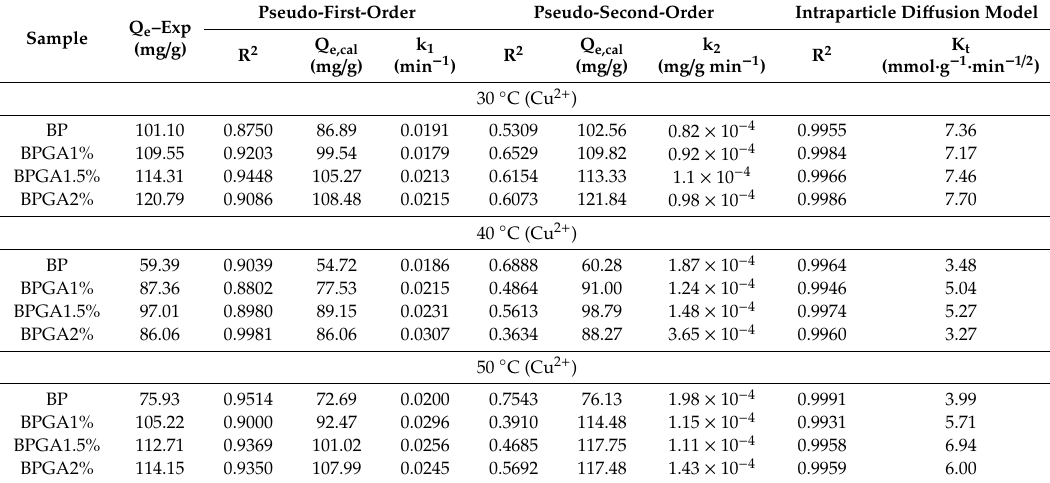
Table 1. Adsorption kinetics parameters for the adsorption of Cu 2 + ions onto the adsorbents. Q e –Exp Sample (mg /